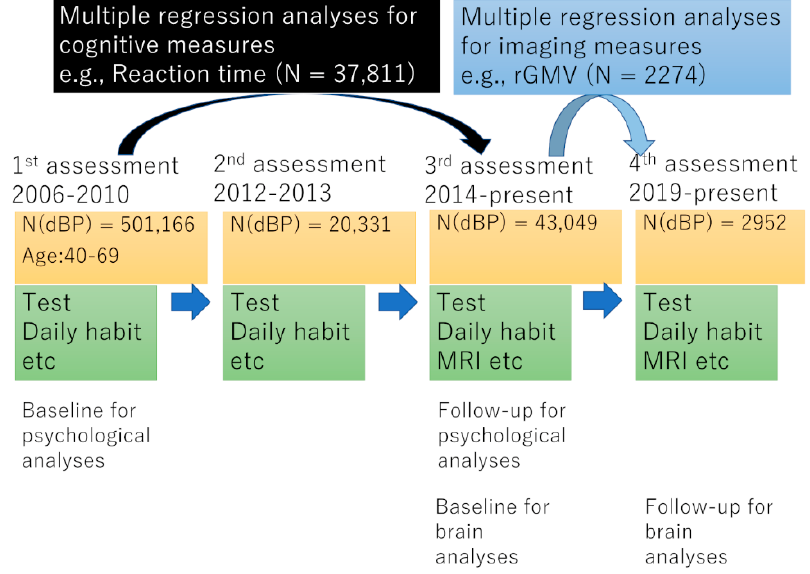
Figure 1. The scheme of study flow and assessment in the UK Biobank and the analyses of the present study. N(dBP) represents numbers of subjects whose data of diastolic blood pressure (BP) are available in each assessment occasion.